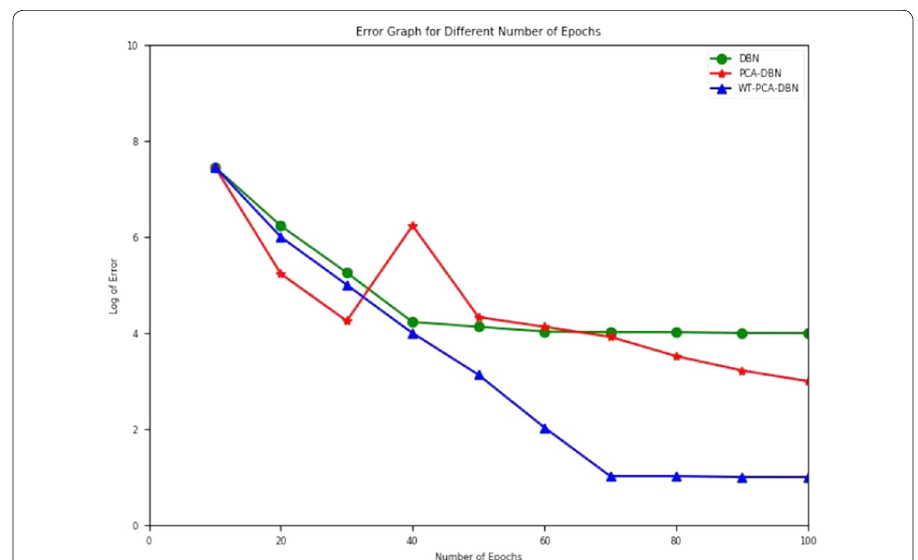
Fig. 10 Error graph for different techniques such as; DBN, PCA-DBN and proposed